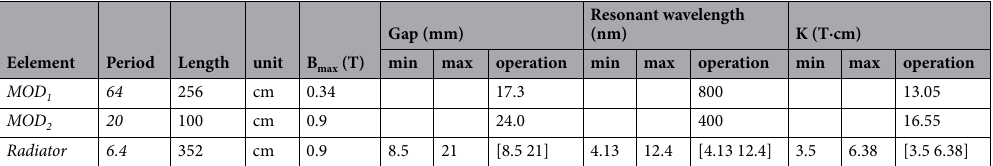
Table 1. The parameters of modulator 1, modulator 2, and radiator are listed, including period, total length, maximum B field, minimum, maximum, and operational gaps, and K parameter.